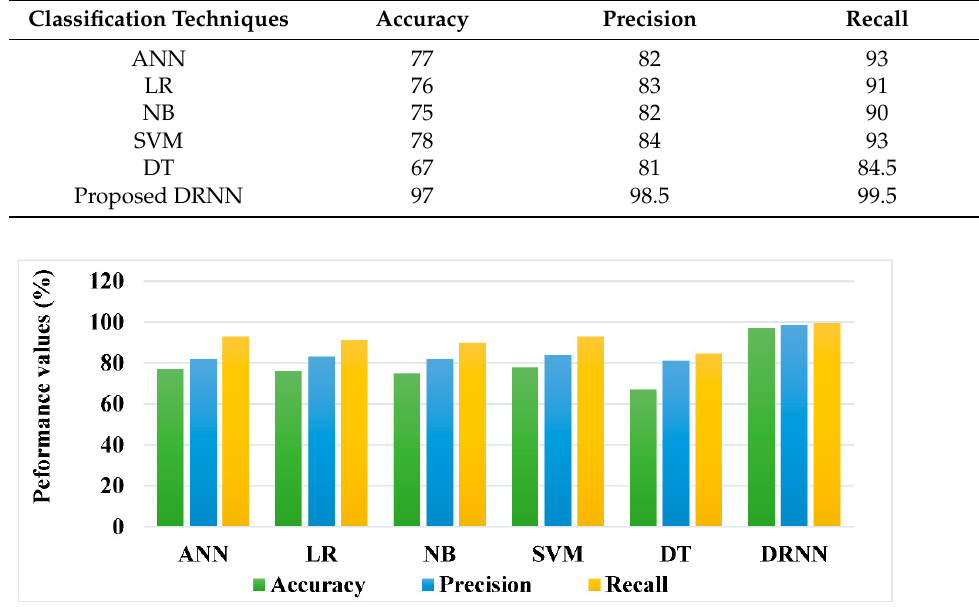
Figure 6. Precision, accuracy, and recall of existing and planned procedures. Table 1. Accuracy, precision, and recall measures of existing and proposed techniques. Table 2. F1-scores and RMSE measures of existing and proposed